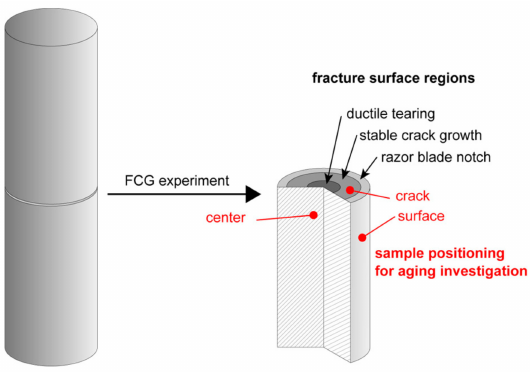
Figure 2. Schematic of the CRB specimen ( left ) before and ( right ) after fatigue crack growth (FCG) experiments indicating the three sample positions (i.e., center, surface, and crack) for the investigation of the corresponding local aging